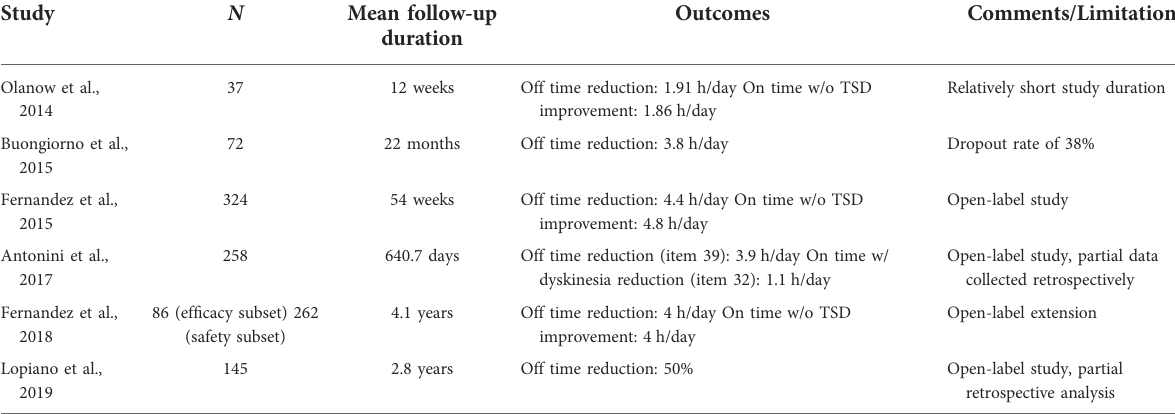
TABLE 1 Key studies evaluating the ef fi cacy of LCIG.